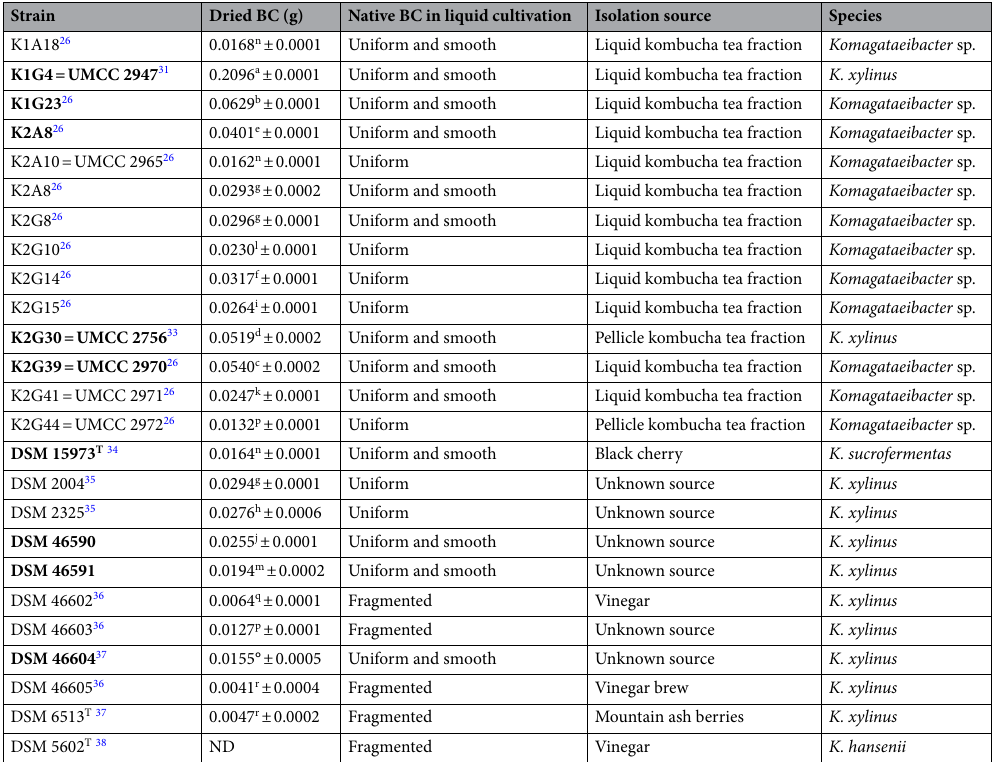
Table 1. Weight of dried BC and shape of native BC produced by AAB strains used in this study and their isolation source. Values are given as mean ± standard deviation (n = 3). Different lowercase letters in the same column indicate significant differences (p < 0.05). Bold fonts refer to strains that were chosen for surface- microstructured BC production. ND not